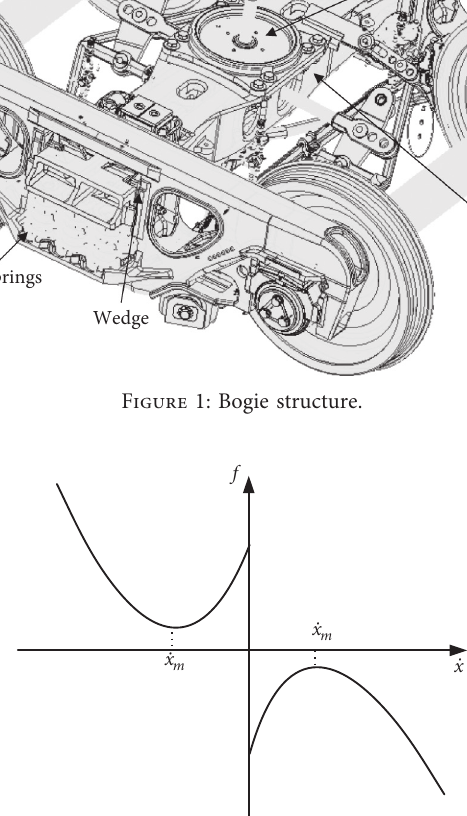
Figure 2: Friction force as a function of velocity.